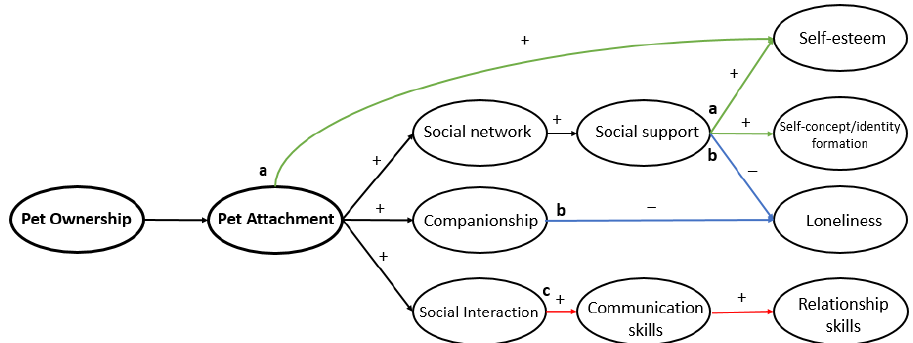
Figure 4. Hypothesized links for the impact of pet ownership and attachment on self-esteem, and loneliness that postulates ( a ) pet attachment directly increases self-esteem, and self-esteem and self-concept are increased indirectly through a wider social network resulting in increased social support (green) and ( b ) loneliness is reduced through a wider social network gained from having a pet, and increased social support and companionship from the pet (blue) and ( c ) relationship and communication skills are honed through increased social interaction (red).